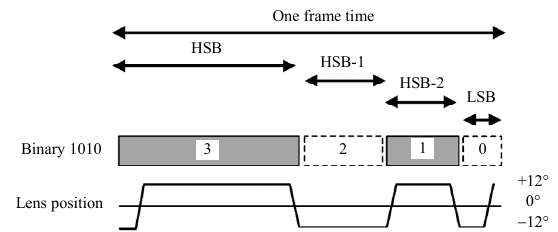
Fig. 2 Schematic diagram of 4-bit pulse width modulation. Pulse width modulation with 1010 binary image data, in which gray represents the time when the micromirror is on and white represents the time when the micromirror is off.